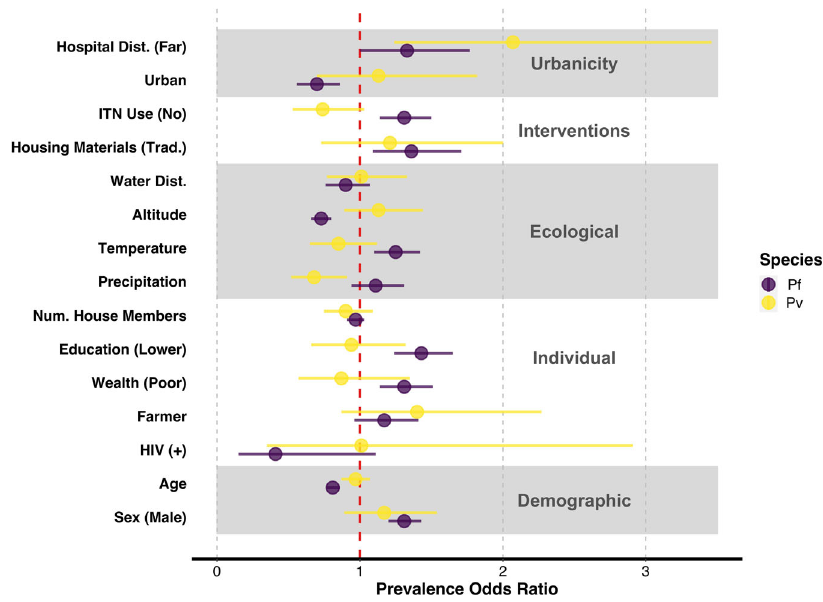
Fig. 2 Inverse probability weight adjusted prevalence odds ratios for expected malaria risk factors. Risk factor point estimates and associated 95% con fi dence intervals are displayed for P. vivax and P. falciparum , respectively. Risk factors associated with P. vivax infection included precipitation and distance from healthcare facilities, while risk factors were associated with P. falciparum infection, included: urbanicity, housing materials, ITN use, altitude, temperature, education, wealth, age, and biological sex. The unadjusted pORs effect estimates and con fi dence intervals as well as the IPW-pORs are provided in Supplementary Table 7 for reference. Hospital Dist distance to healthcare facilities, Water Dist. distance to water, Trad. traditional, Num. House Members number of household members, ITN insecticide-treated